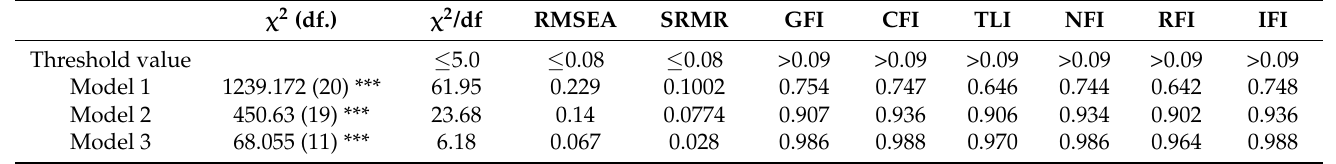
Table 4. Fit indices of models in the CFA of the Fear of COVID-19 Scale in test sample 2. χ 2 (df.)